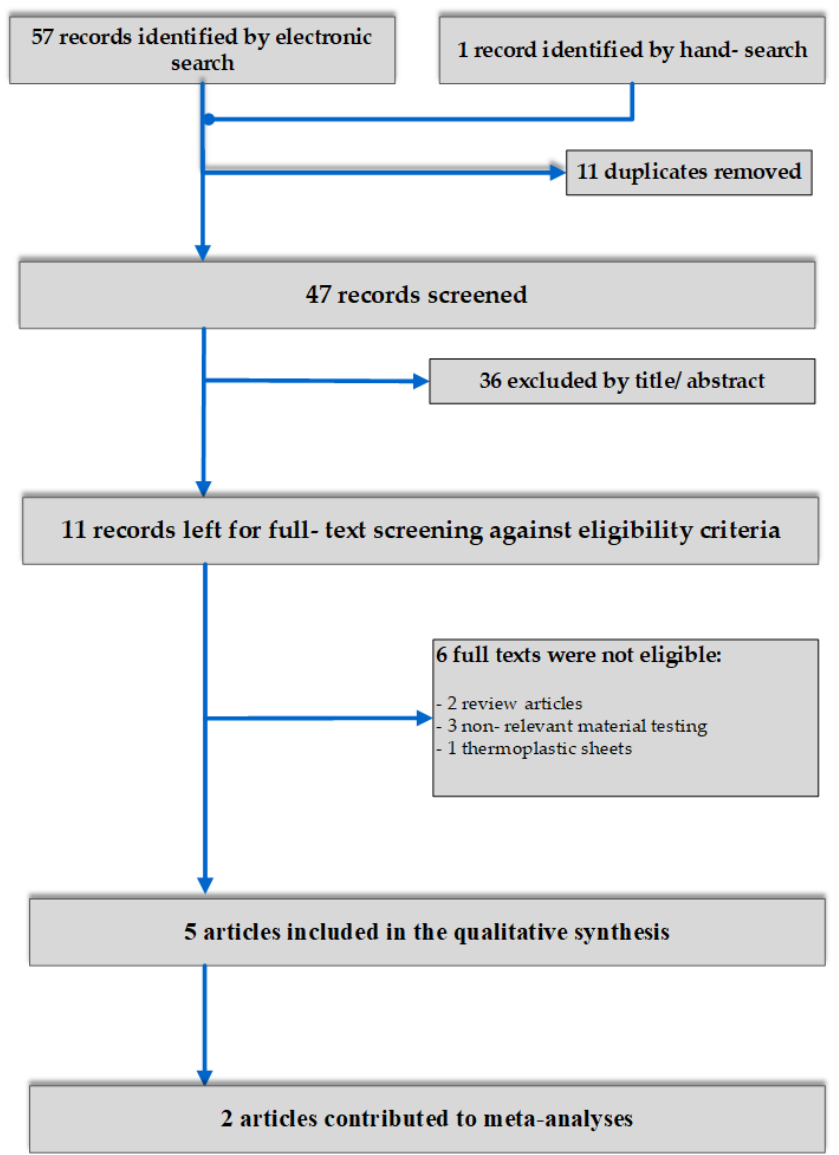
Figure 1. Flow diagram of study selection.